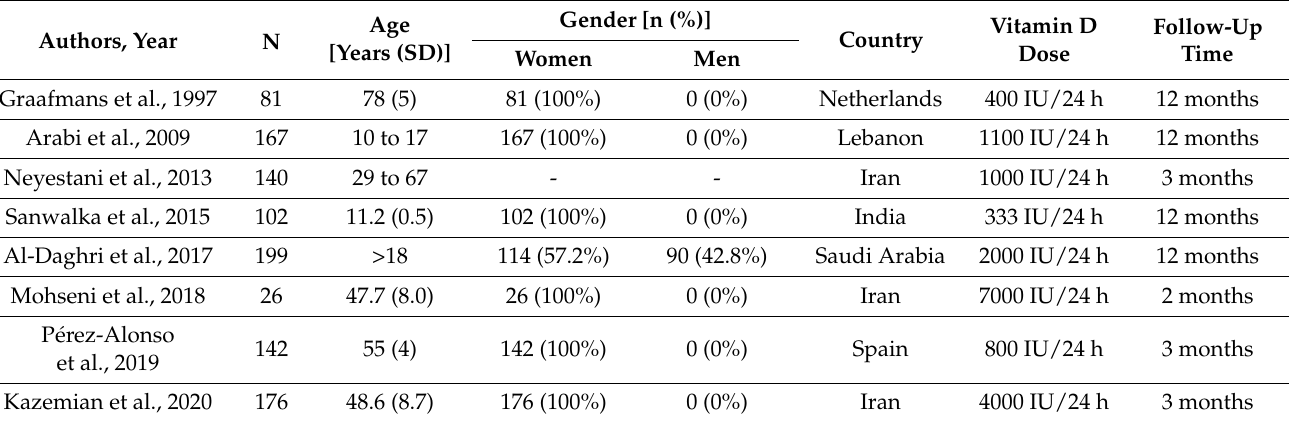
Table 1. Characteristics of the studies included in the